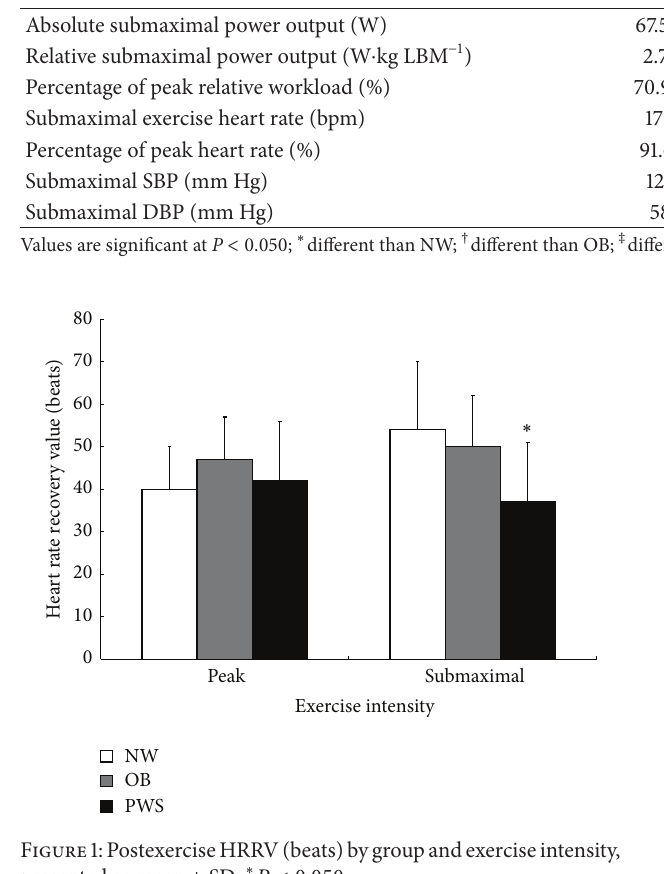
Figure1:PostexerciseHRRV(beats)bygroupandexerciseintensity, presented as mean ± SD; ∗ 𝑃 < 0.050